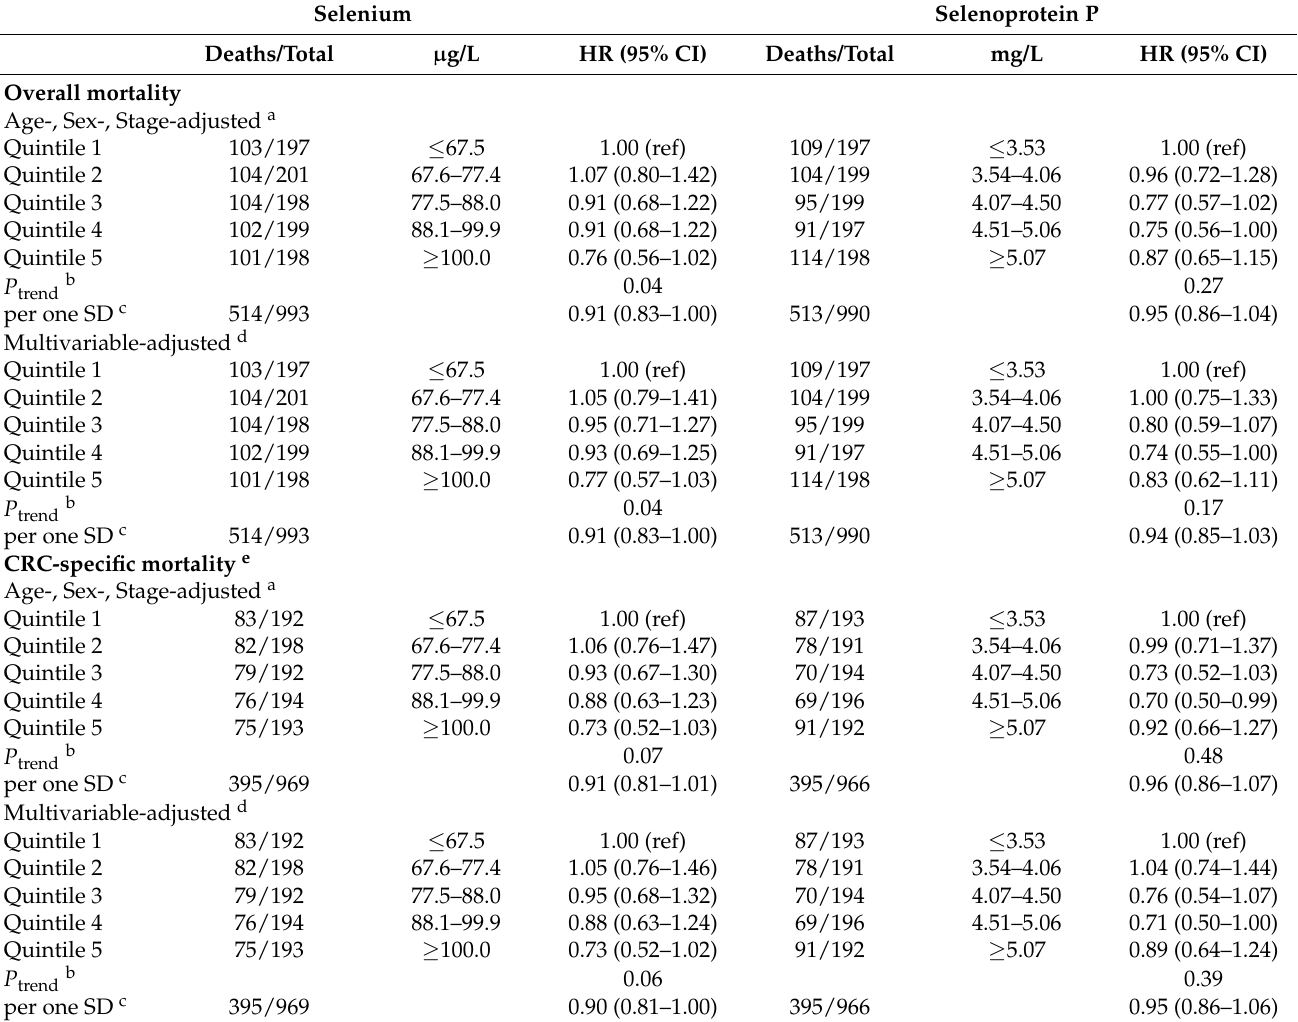
Table 2. HRs and 95% CIs for overall and CRC-specific mortality according to quintiles of prediagnostic serum Se and SELENOP among CRC cases in the EPIC